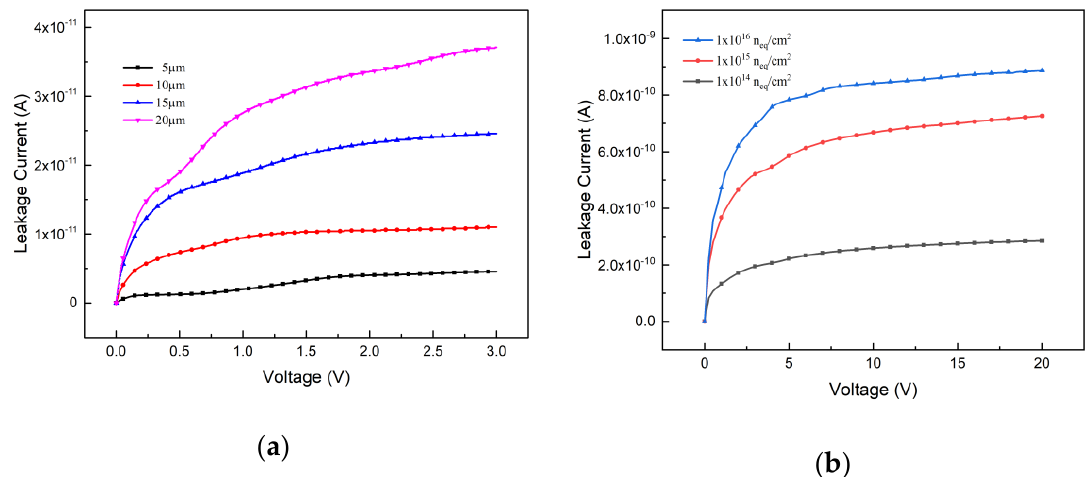
Figure 2. Leakage current curves v.s. bias voltage; ( a ) With the influence of the electrode spacing; ( b ) With the influence of the radiation fluence.